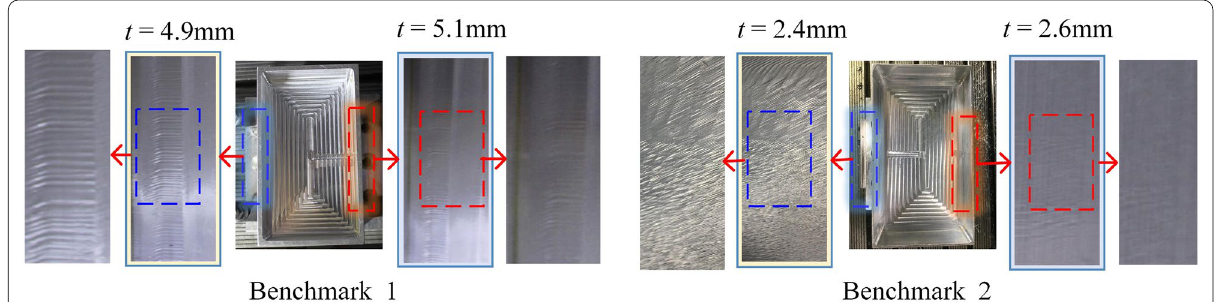
Figure 13 Machining results of benchmark_1 and